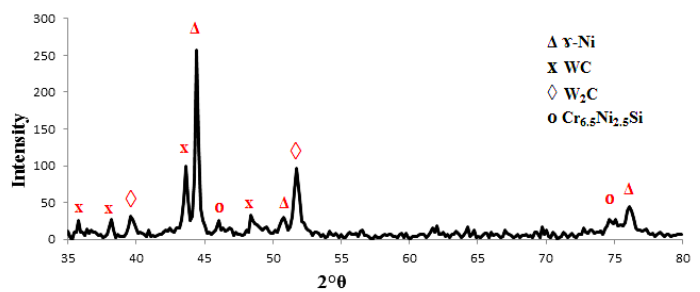
Figure 10. XRD spectra of the 40NiCrBSi + 60WC blended powder.